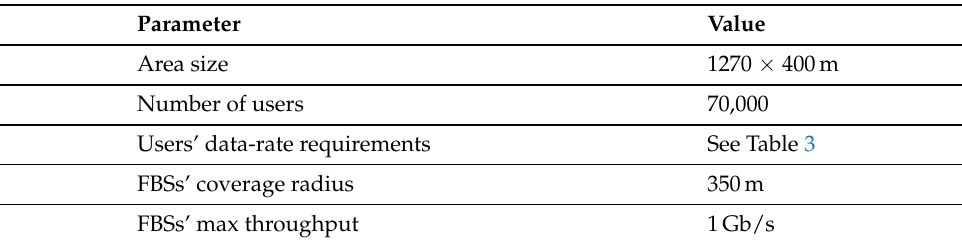
Table 5. Scenario parameters. Parameter Value Area size